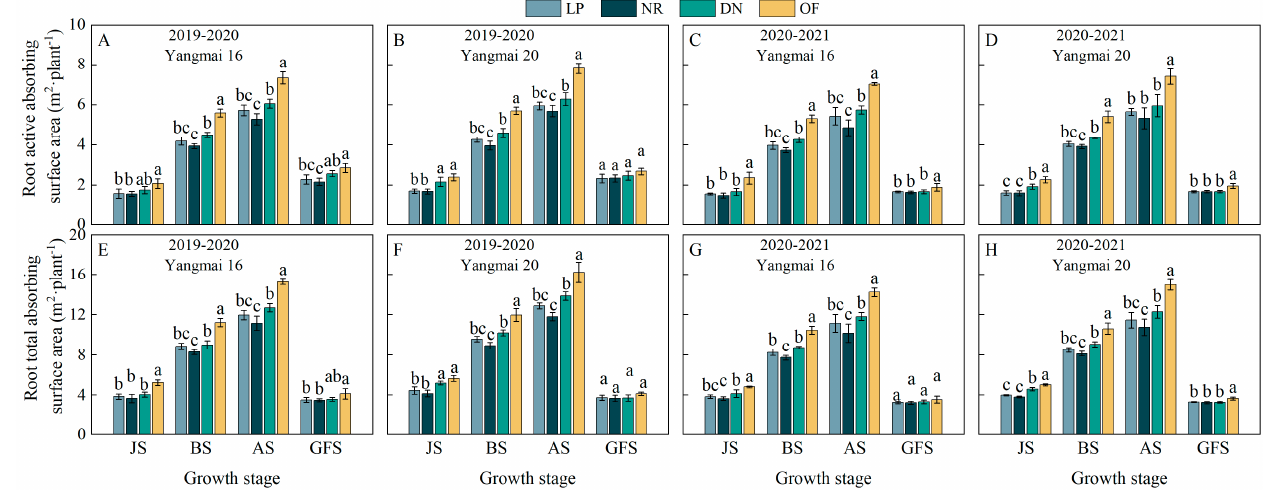
Figure A1. Effect of integrated cultivation practices on the root active absorbing surface area ( A – D ) and root total absorbing surface area ( E – H ) of wheat. LP, NR, DN, and OF indicate local practices, nitrogen reduction, planting density reduction and nitrogen reduction, and organic fertilizer, respectively. JS, BS, AS, and GFS indicate the jointing stage, booting stage, anthesis stage, and grain filling stage, respectively. Vertical bar represents the ±standard error of the mean. Different lowercase letters indicate the same period; the difference between different treatments was significant at the 0.05 level.